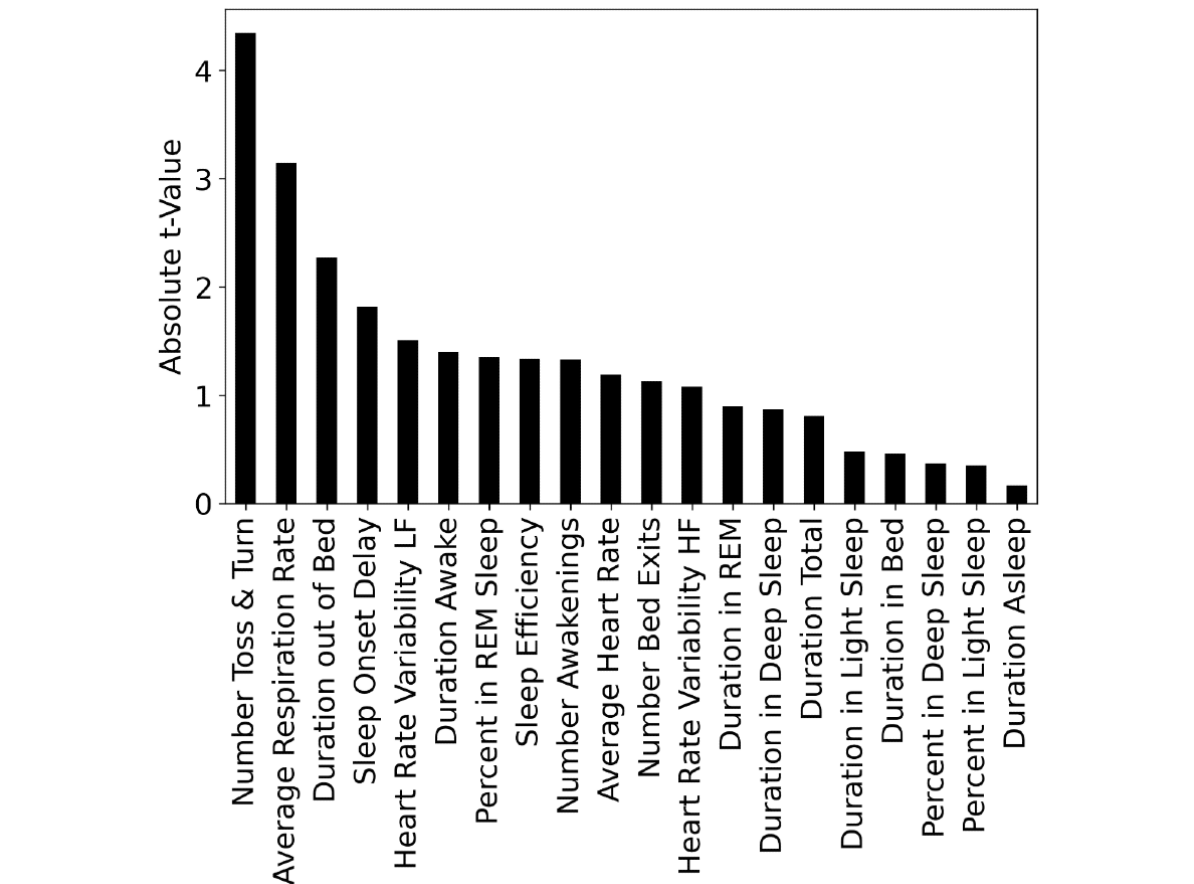
Figure 2. Ranking of self-rated perceived health based on individual linear mixed effects